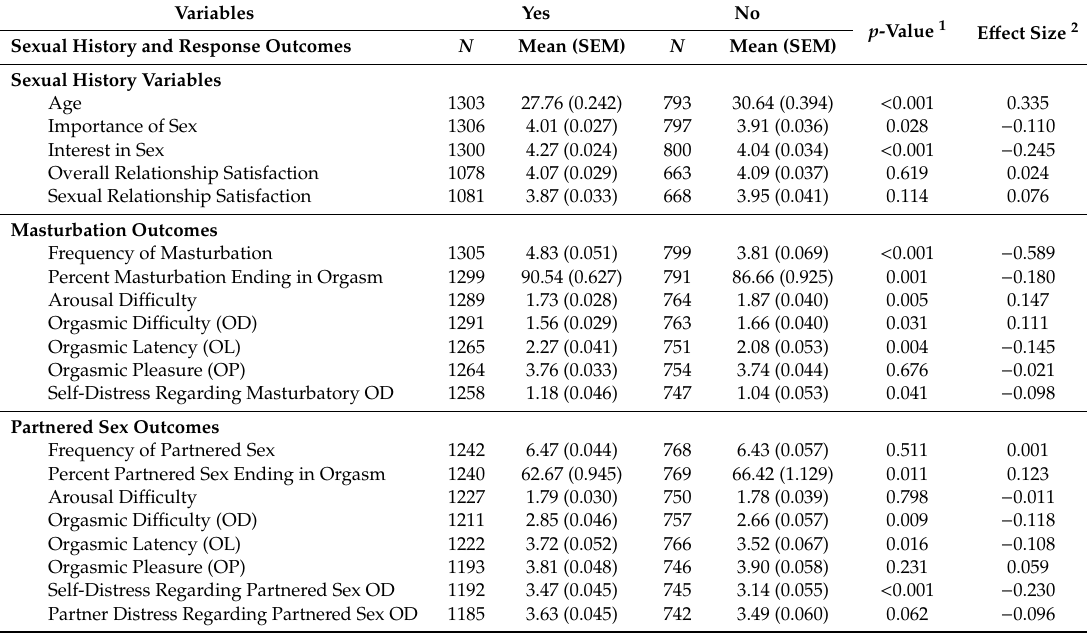
Table 2. Comparison of women’s sexual response outcomes based upon whether or not they engage in pornography use during masturbation.